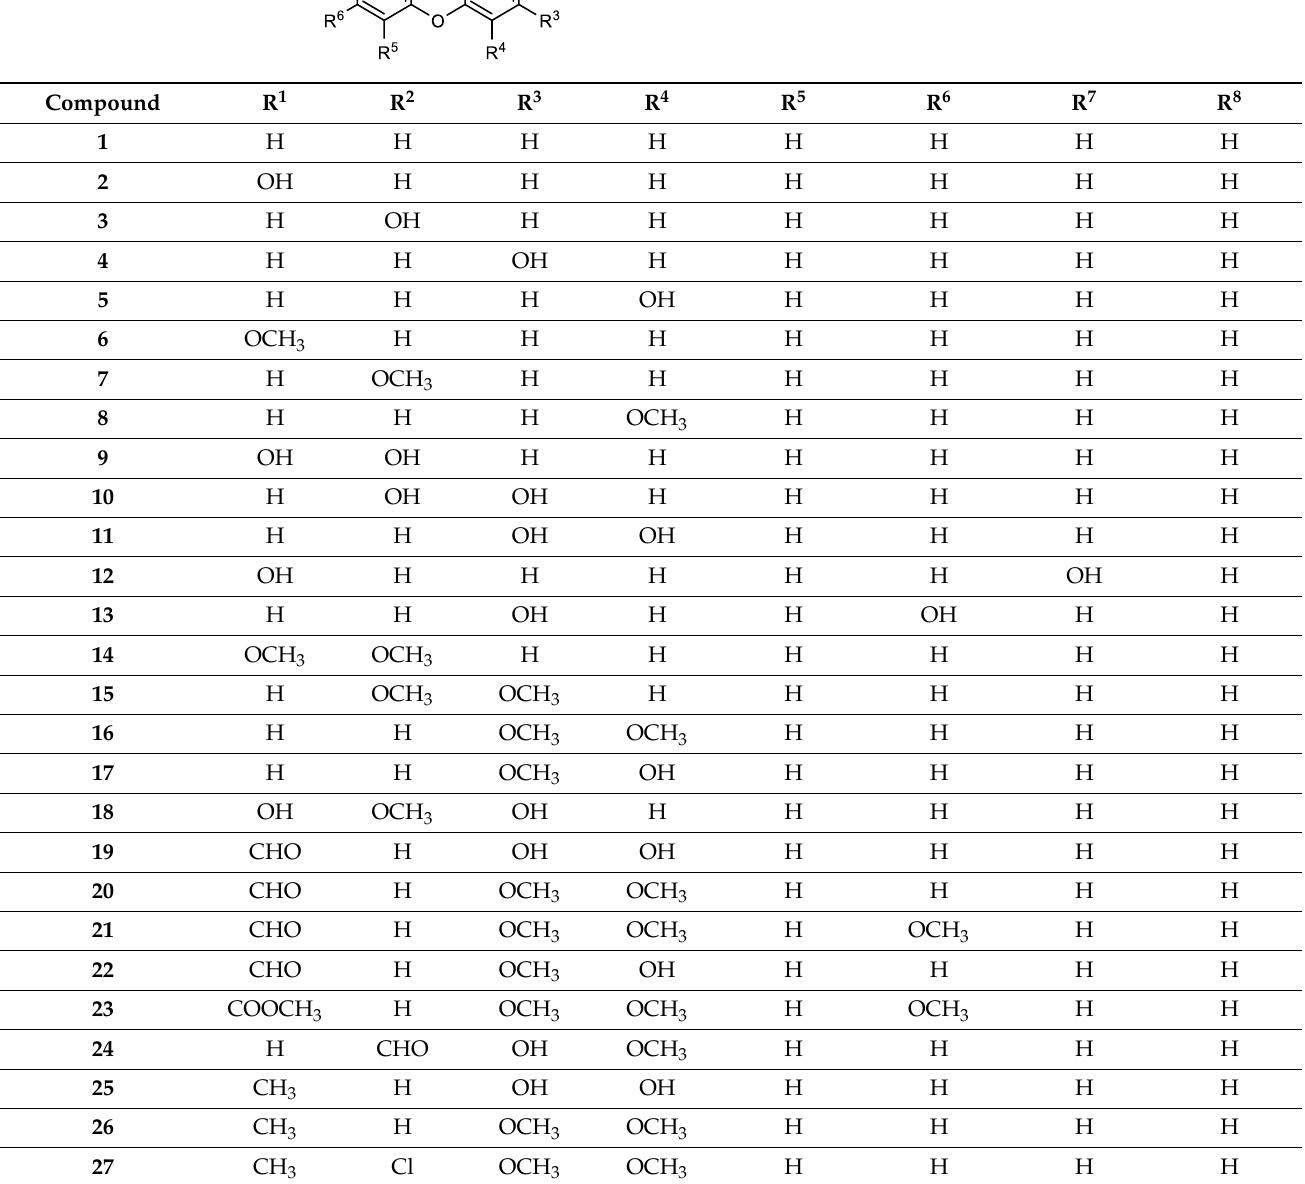
Table 1. Structure of xanthones 1 – 40 .